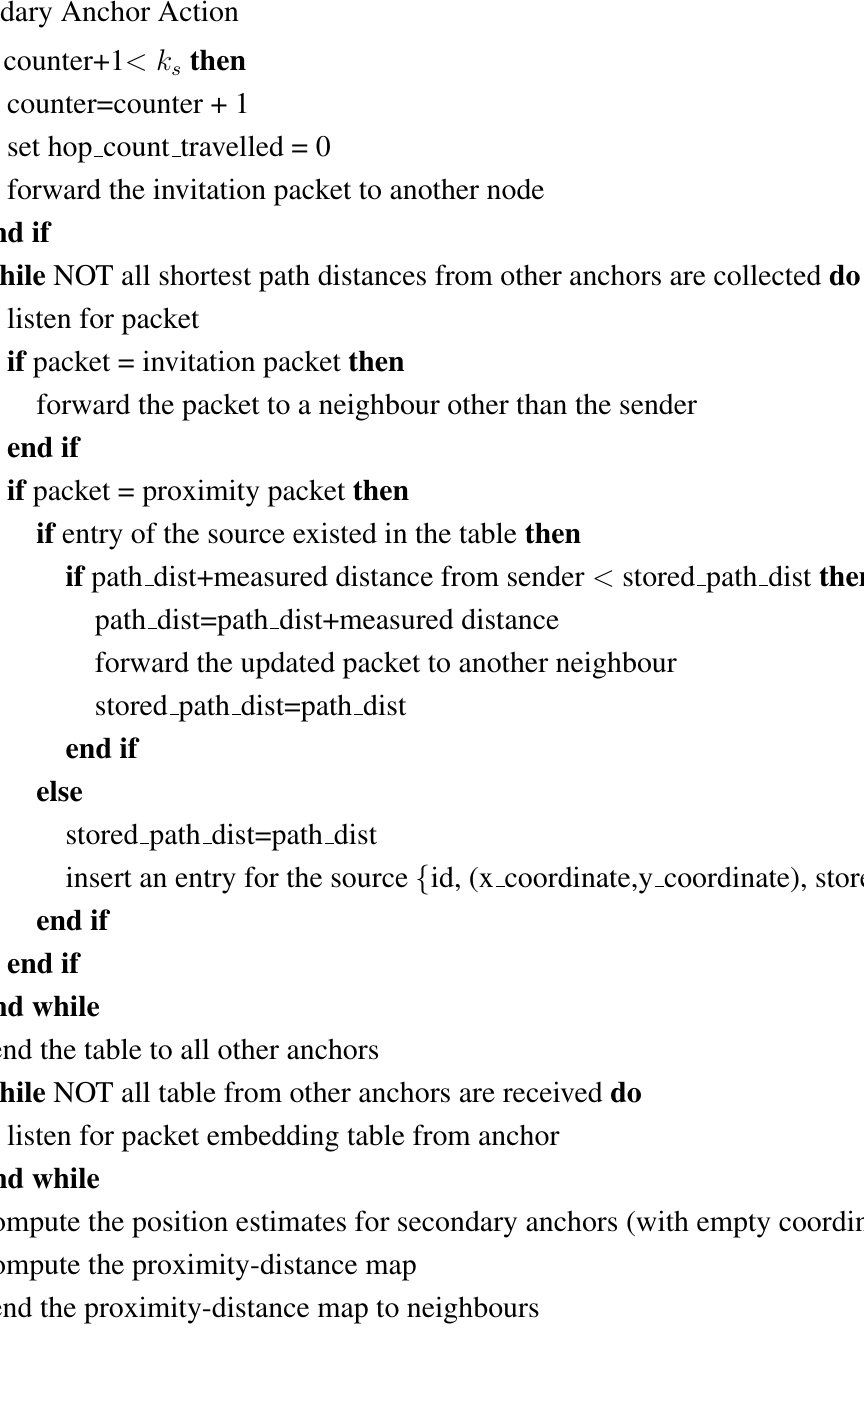
Figure 24 . The Pseudo-code of a Secondary